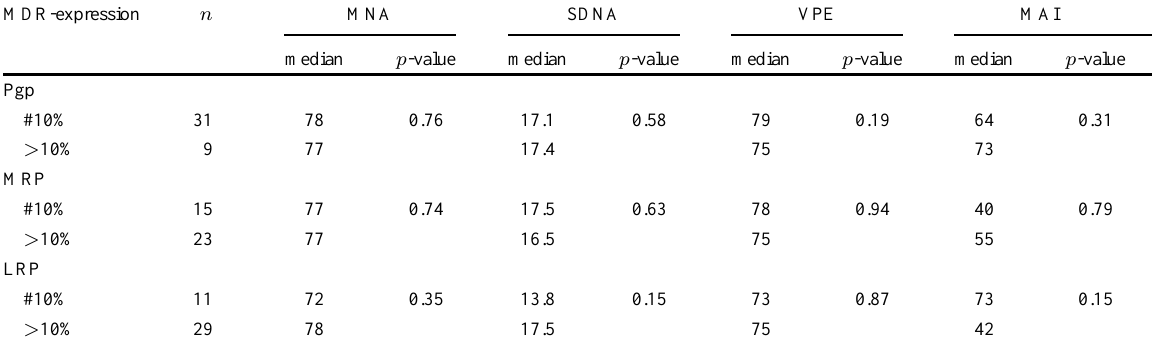
Correlations between quantitative pathologic variables and expression of MDR-related proteins in 40 patients with advanced ovarian cancer (Mann–Whitney test) MDR-expression